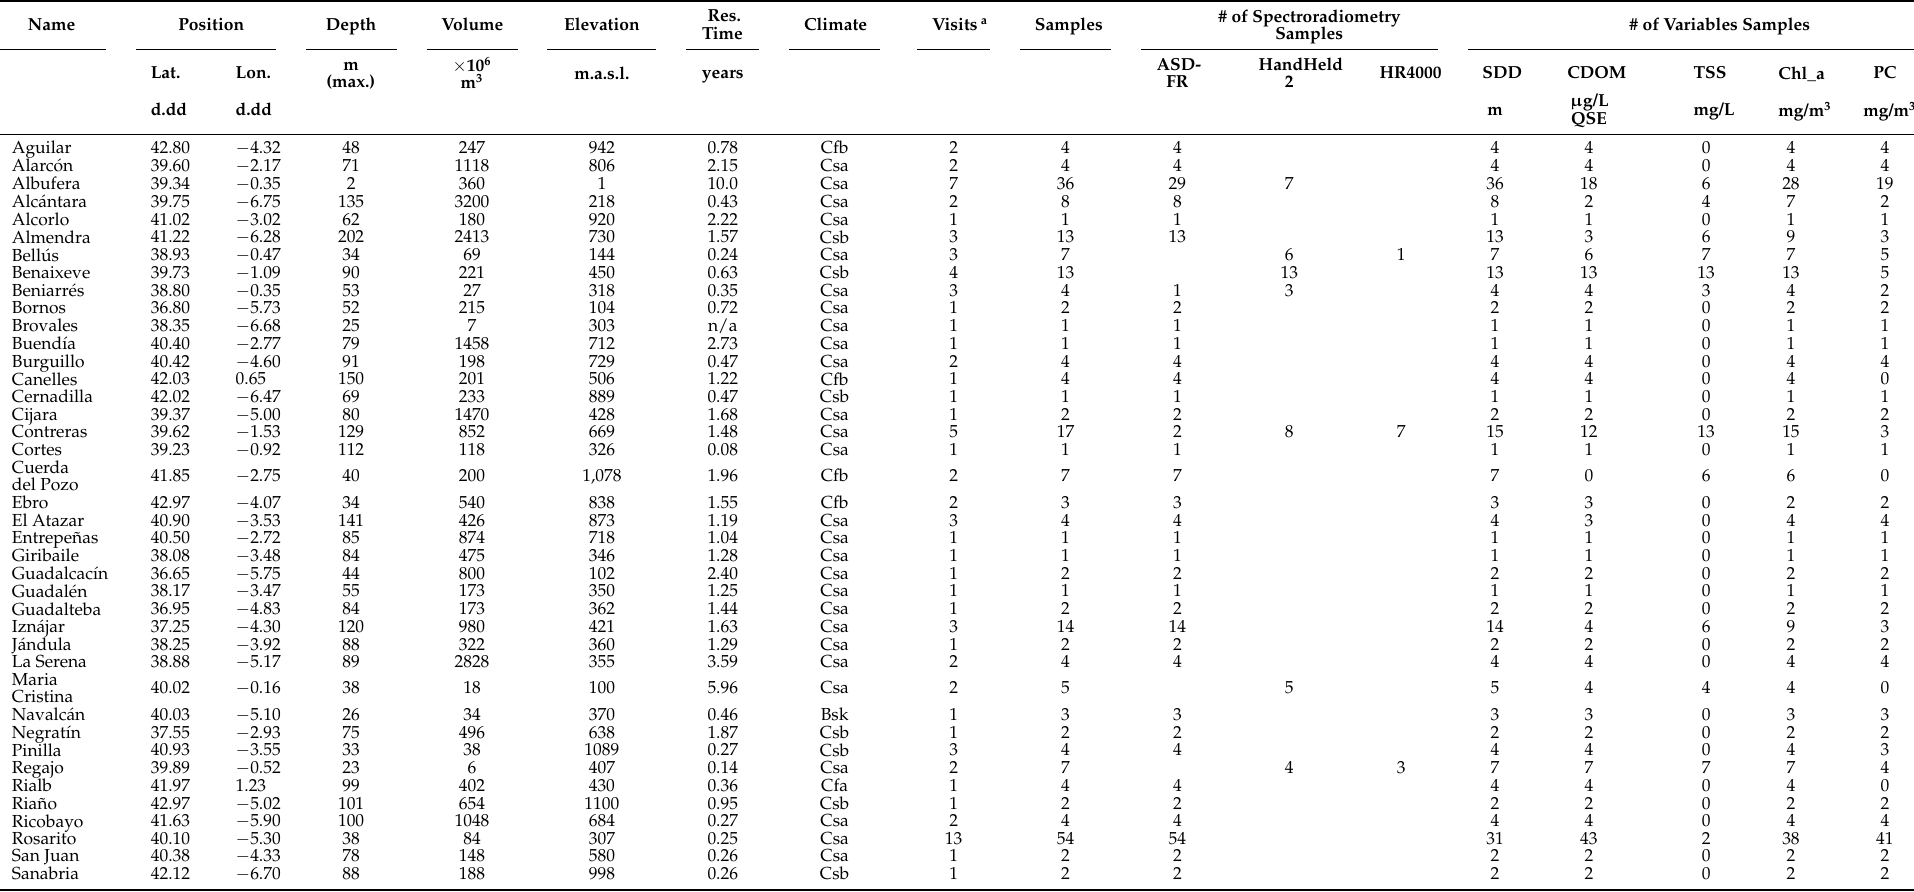
Table A1. Summary of sampled lakes and reservoirs. Symbols and abbreviations: max.: maximum; m.a.s.l.: meters above sea level; lat.: latitude; lon.: longitude; Res.: residence. a Visits spanning 2 days counted as